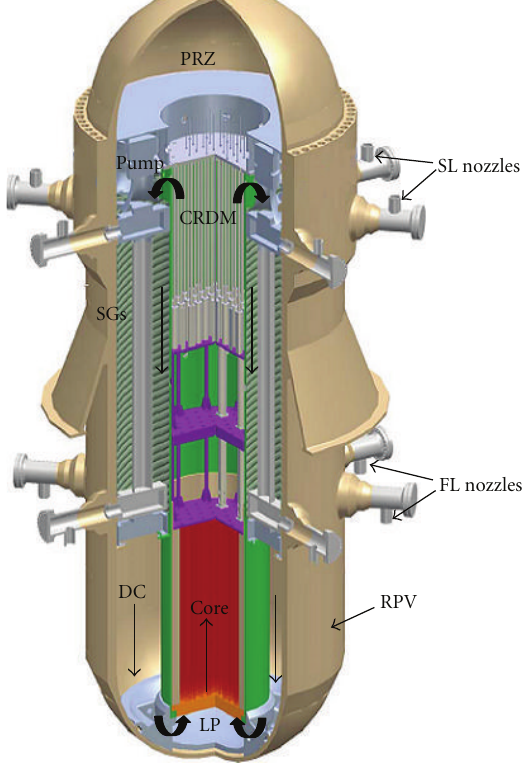
Figure 1: IRIS integral